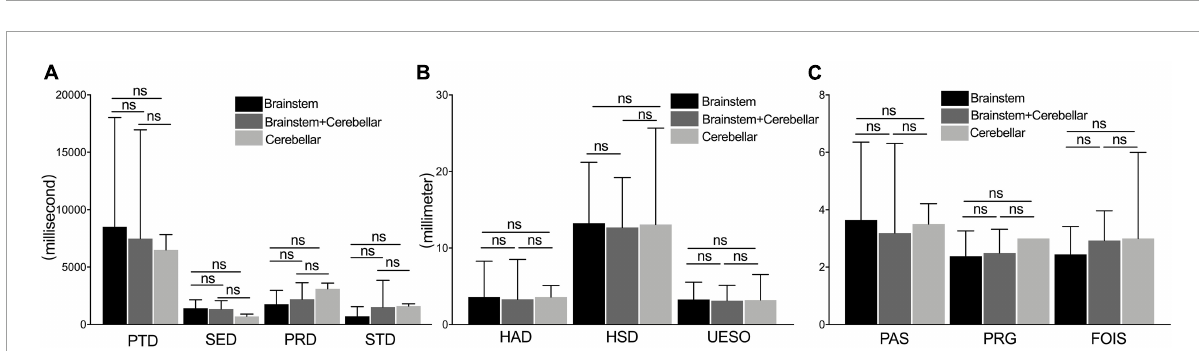
FIGURE6 The comparison of measures among the brainstem, cerebellar, and brainstem + cerebellar stroke subgroup. The measures of duration (A) , motion (B) , and pharyngeal function (C) under a videofluoroscopic swallowing study examination between the brainstem stroke group, the brainstem add the cerebellar stroke, and cerebellar stroke subgroup. PAS, Penetration-Aspiration Scale; FOIS, Functional Oral Intake Scale; PRG, Pharyngeal Residual Grade; PTD, pharyngeal transit duration; HAD, hyoid bone anterior-horizontal displacement; HSD, hyoid bone superior-horizontal displacement; SED, soft palate elevation duration; PRD, pharyngeal response duration; STD, stage transition duration; UESO, upper esophageal sphincter opening. ns, not